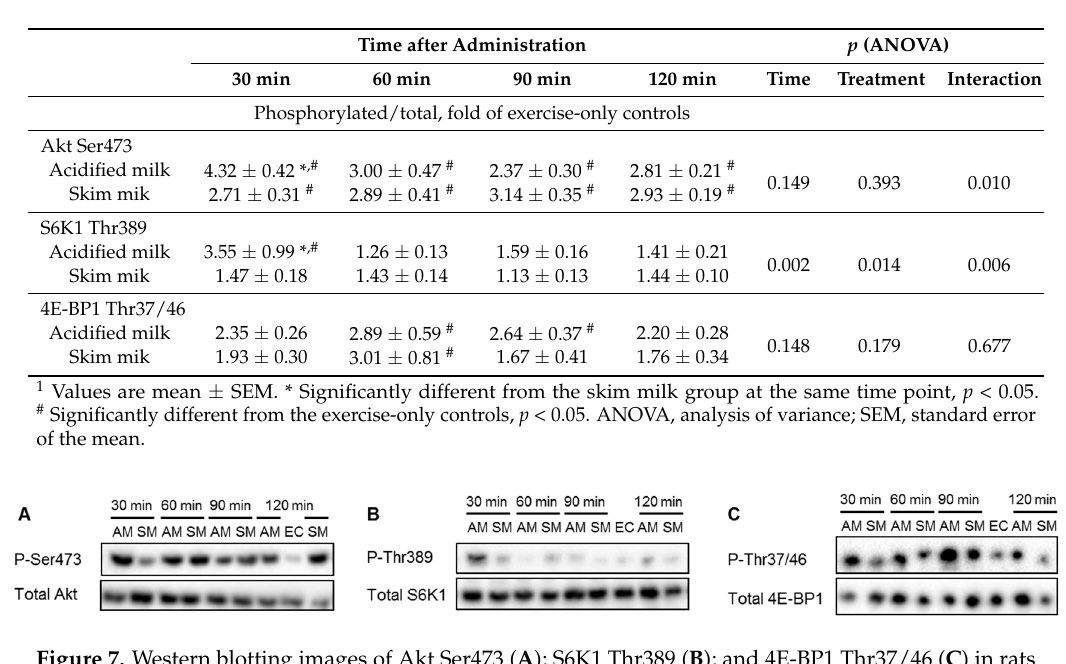
Figure 7. Western blotting images of Akt Ser473 ( A ); S6K1 Thr389 ( B ); and 4E-BP1 Thr37/46 ( C ) in rats administered acidified milk or skim milk. AM, acidified milk; SM, skim milk; EC, exercise-only controls.